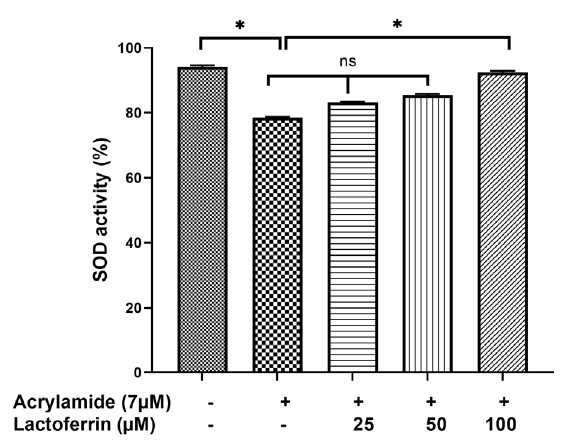
Figure 4. Protective effect of lactoferrin on superoxide dismutase activity rate against acrylamide-induced oxidative stress in HepG2 cells. The results were shown with mean±standard deviation. ns: not significant * p <